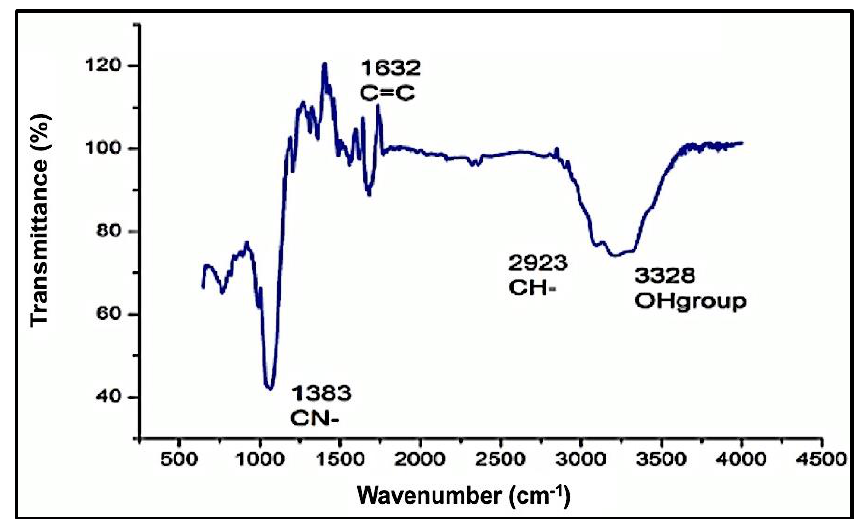
Figure 4. Fourier-transform infrared spectrum (FTIR) of the investigated ZnO-NPs. Table 1. Values of the FTIR spectrum bands of the investigated ZnO-NPs.